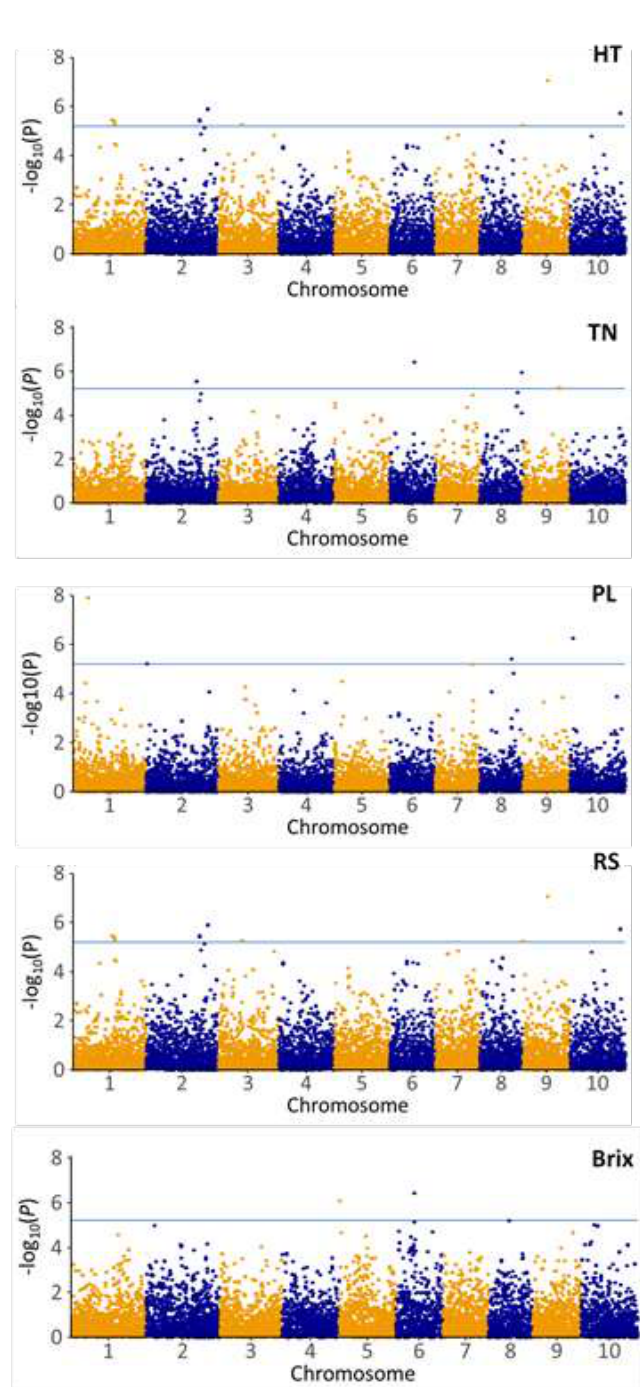
Figure 4. Manhattan plot of genome-wide association analysis of plant height (HT), tiller number (TN), internode number (IN), panicle length (PL), panicle weight (PW), reducing sugar (RS), and Brix. Lines indicate threshold for significant single nucleotide polymorphisms (SNPs). The x -axis indicates the physical position of the SNPs on the ten sorghum chromosomes. Table 4. Significant associations of single nucleotide polymorphism (SNP) with traits of plant height (HT), tiller number (TN), panicle length (PL), Brix, and reducing sugar (RS) in the population across three environments.